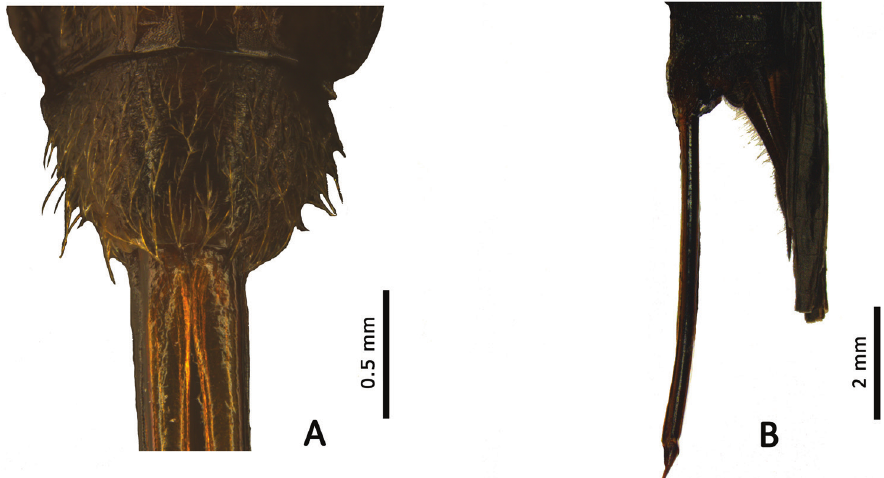
Figure 4. Qingryllus jiguanshanensis sp. n. Female. A Subgenital plate, ventral view B Ovipositor, lateral